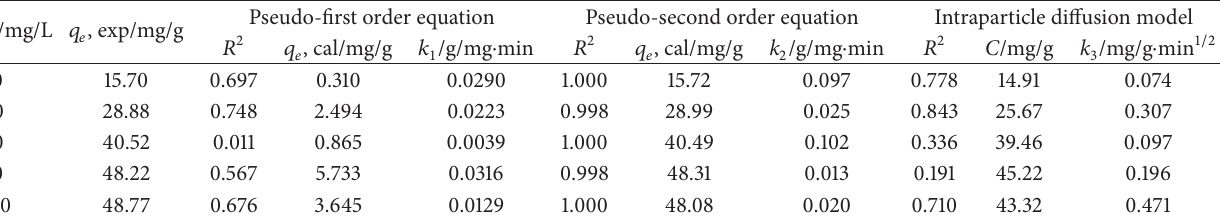
Table 3: Kinetic parameters for MB adsorption on WS.